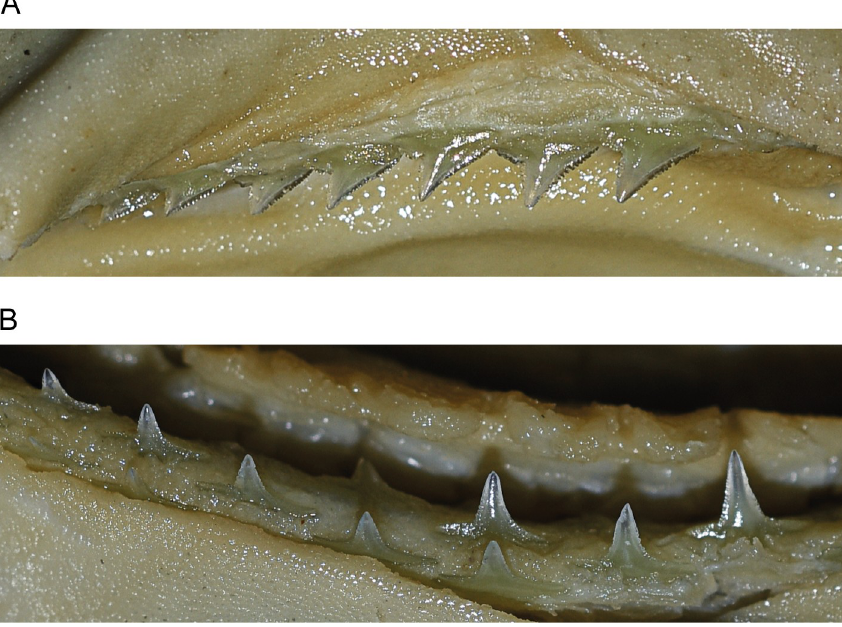
Fig 5. In situ teeth of Carcharhinus obsolerus sp. nov. (ANSP 77121, paratype). 370 mm TL female: A. upper teeth; B. lower